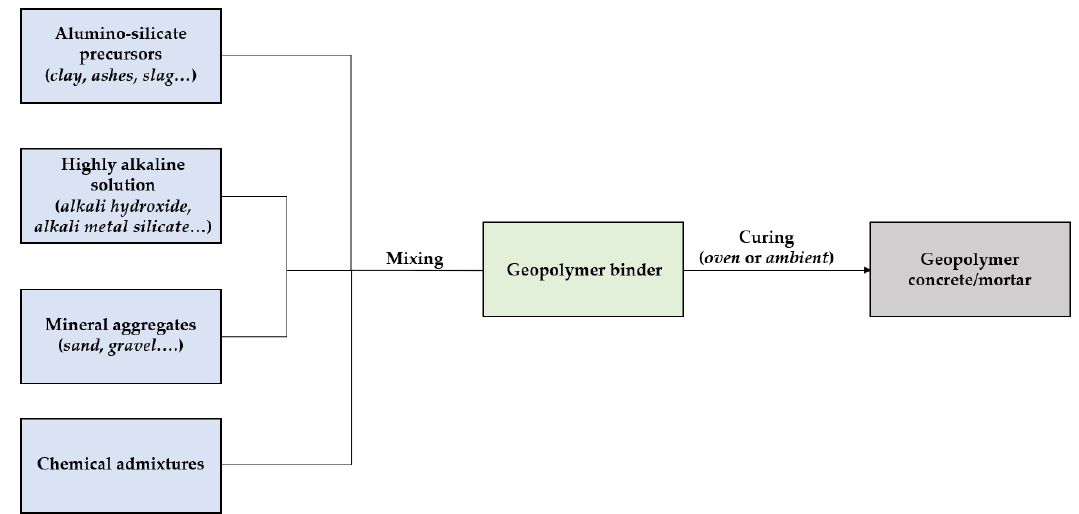
Figure 7. Production of geopolymer concrete. A descriptive model.